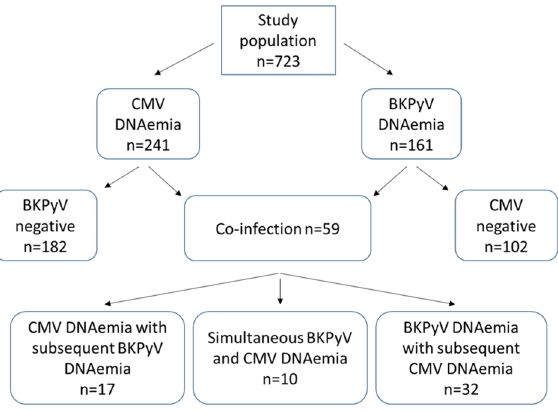
Figure 1. Overview of the different constellations of BKPyV and CMV viremia in our patient